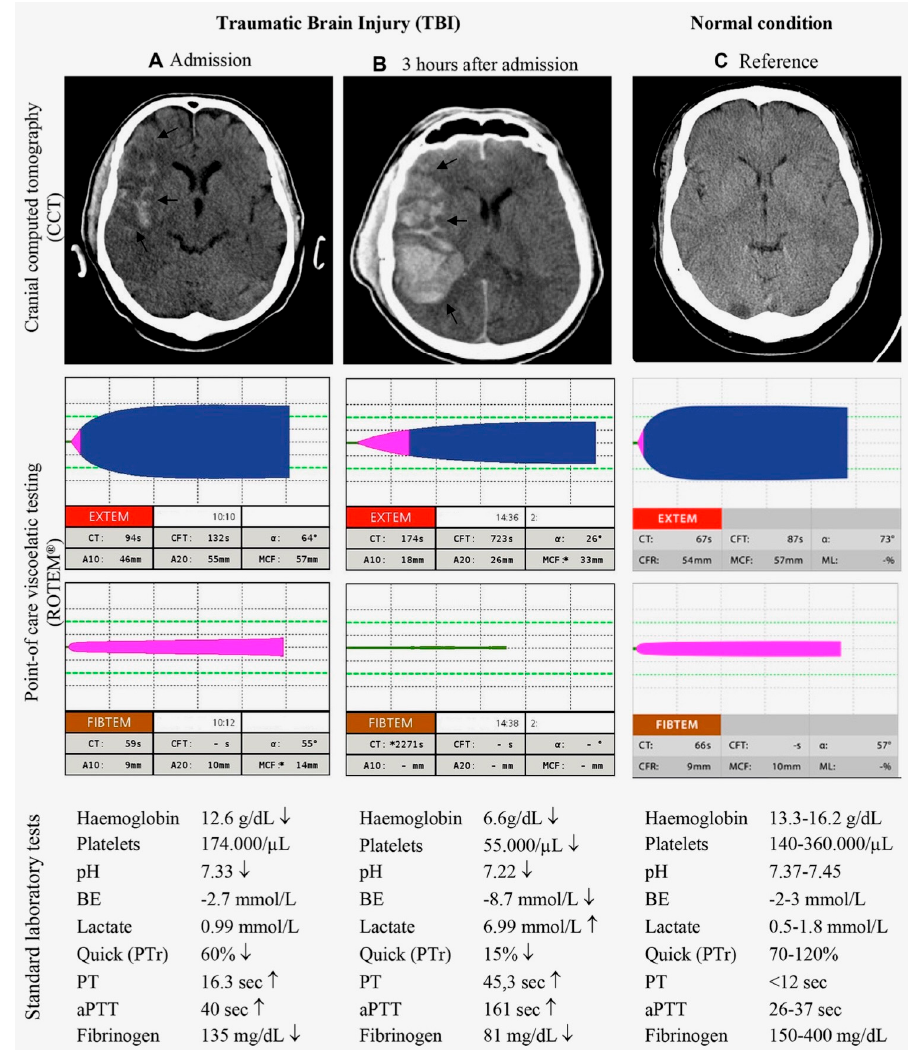
Figure 2. Clinical example of a patient with severe TBI and initial coagulopathy who developed complicating subsequent hypotensive (multifactorial) coagulopathy with deteriorating ICH within three hours of hospital admission. Shown are cranial computed tomographies of the brain (CCTs), results from viscoelastic (ROTEM ® ), and standard laboratory and conventional coagulation assays (CCAs) upon admission ( A ) and after three hours of admission ( B ). A normal reference condition is displayed for comparison ( C ). Viscoelastic assays after three hours of admission indicate delayed and insu ffi cient clo tt ing, as re fl ected by prolonged initiation times and reduced clot amplitudes. The fl at line in the ROTEM ® FIBTEM channel re fl ects the complete absence of fi brin polymerization. Results from standard laboratory assays and CCAs three hours after admission display signs of shock with deranged coagulation along with hypo fi brinogenemia and thrombocytopenia. aPTT = activated Partial Thromboplastin Time; BE = base excess; PT = Prothrombin Time; PTr = Prothrombin ratio. First published by Maegele et al. [3], with permission from Elsevier; Reprinted from Maegele et al. [7], with permission from Wolters Kluwer Health, Inc.